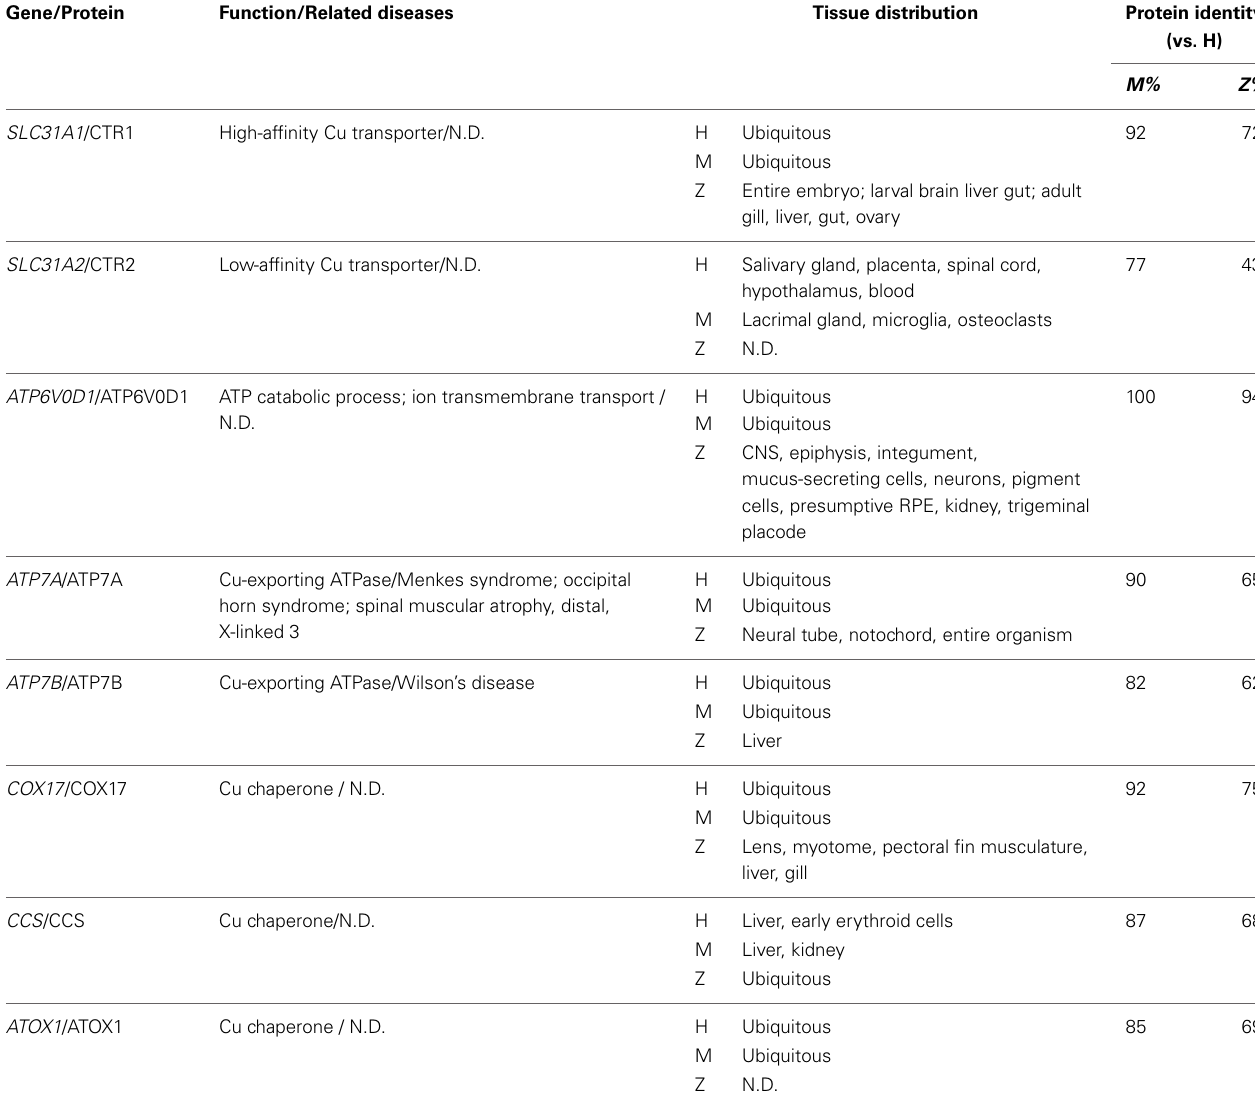
Table 5 | Copper metabolism–related proteins in zebrafish, mice and humans. Gene/Protein Function/Related diseases Tissue distribution Protein identity